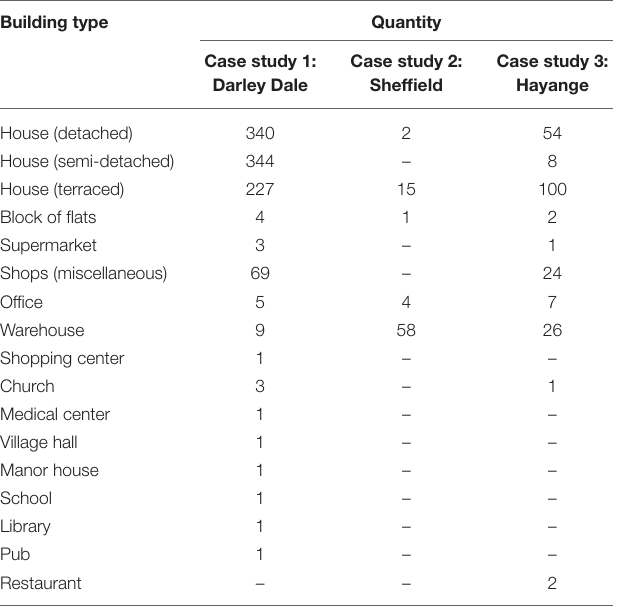
TABLE 2 | Buildings used in each case study